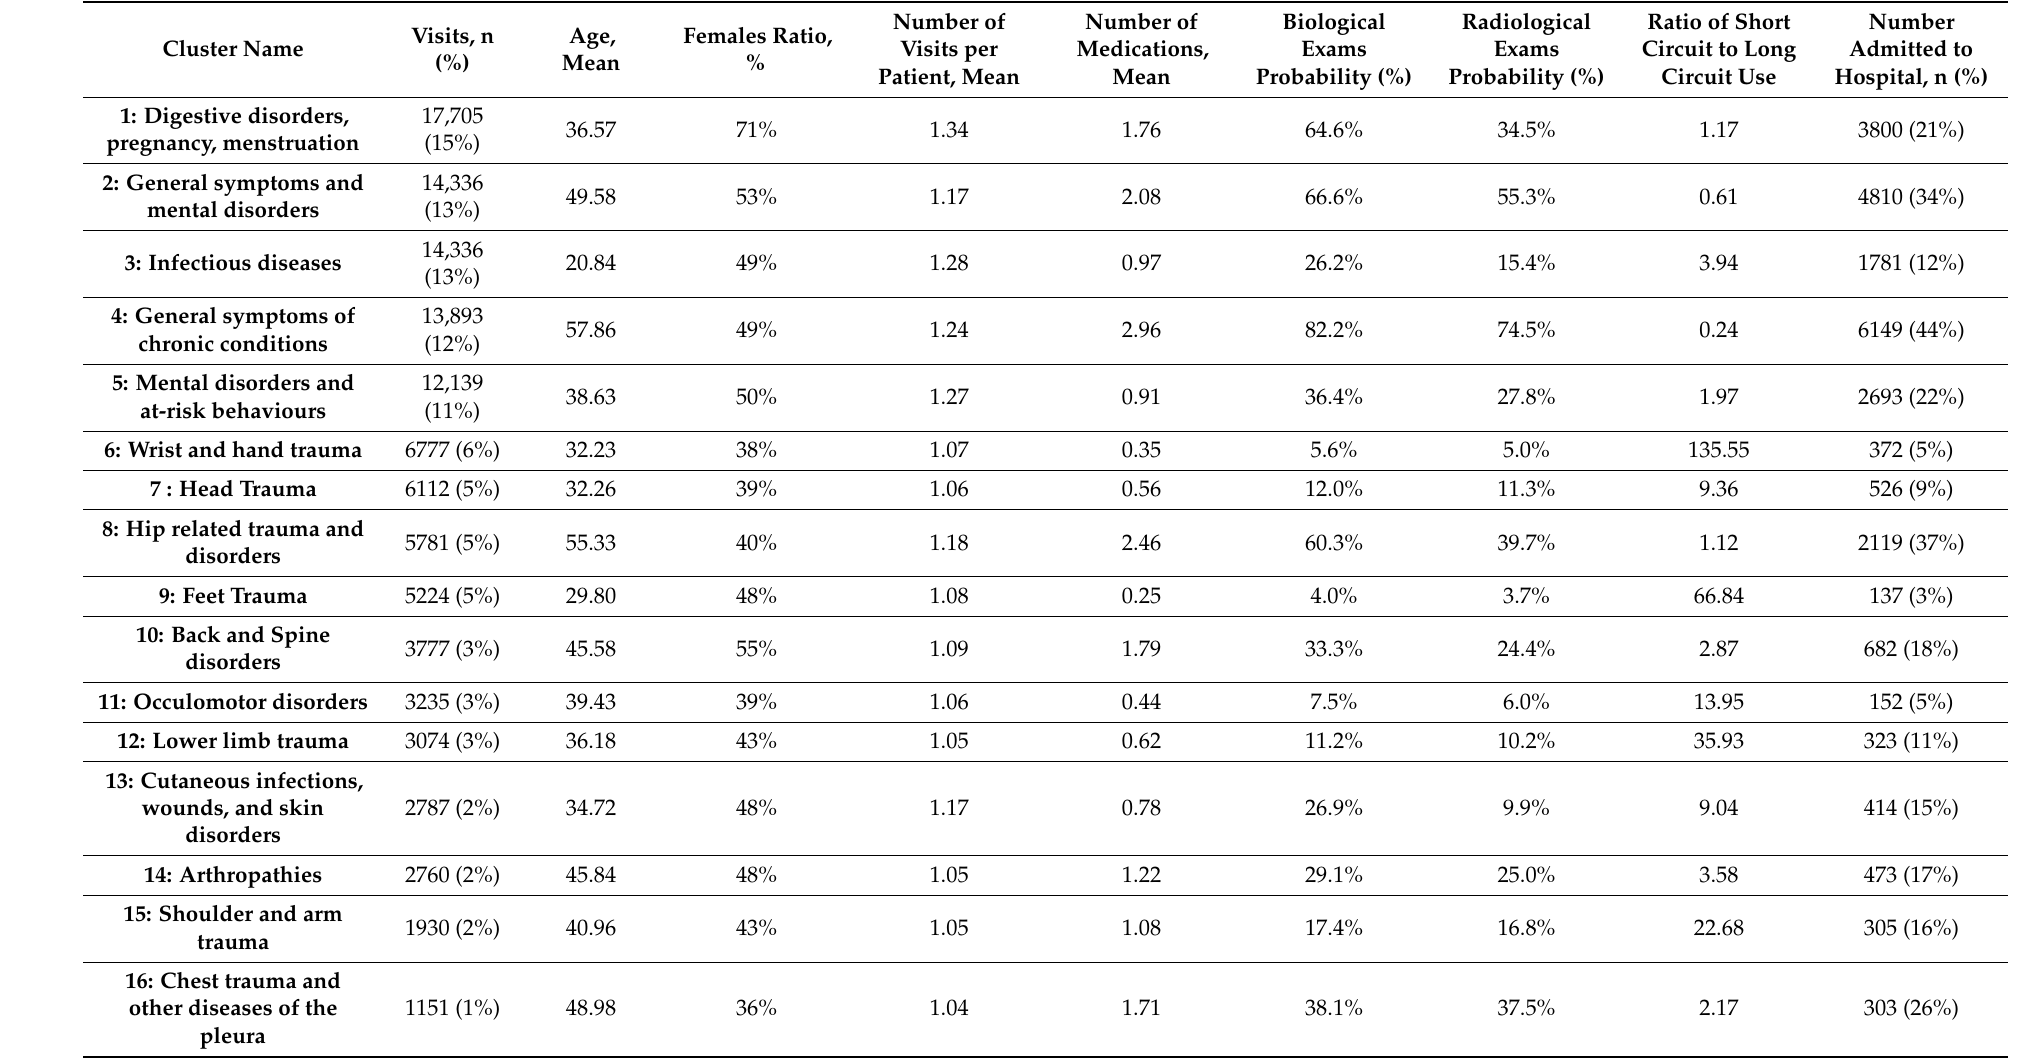
Table 3. Sociodemographic and clinical characteristics of the 16